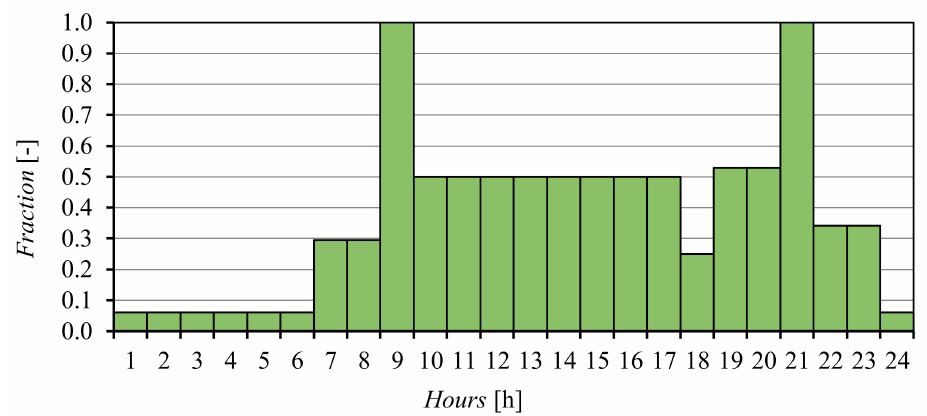
Figure 10. Daily schedule of using sanitary facilities in the bathroom by residents in the event of their